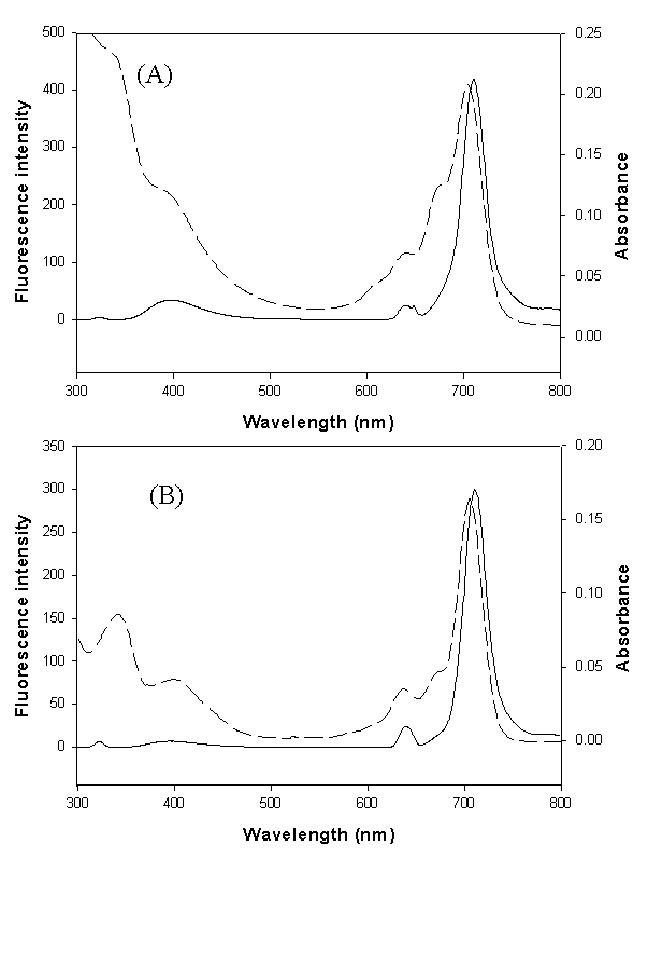
Figure 1. Fluorescence (solid line) and absorption (dashed line) spectra of (A) 3a and (B) 3b